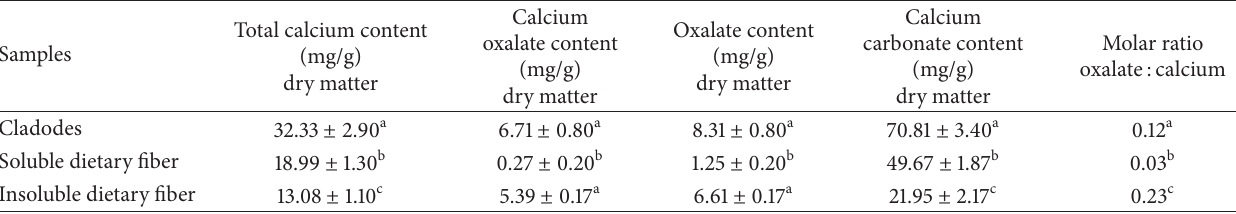
Table1:Totalcalcium,oxalate,calciumcarbonatecontent,andmolarratiooxalate :calciumin Opuntiaficusindica samples(cladodes,soluble, and insoluble dietary fiber) ∗